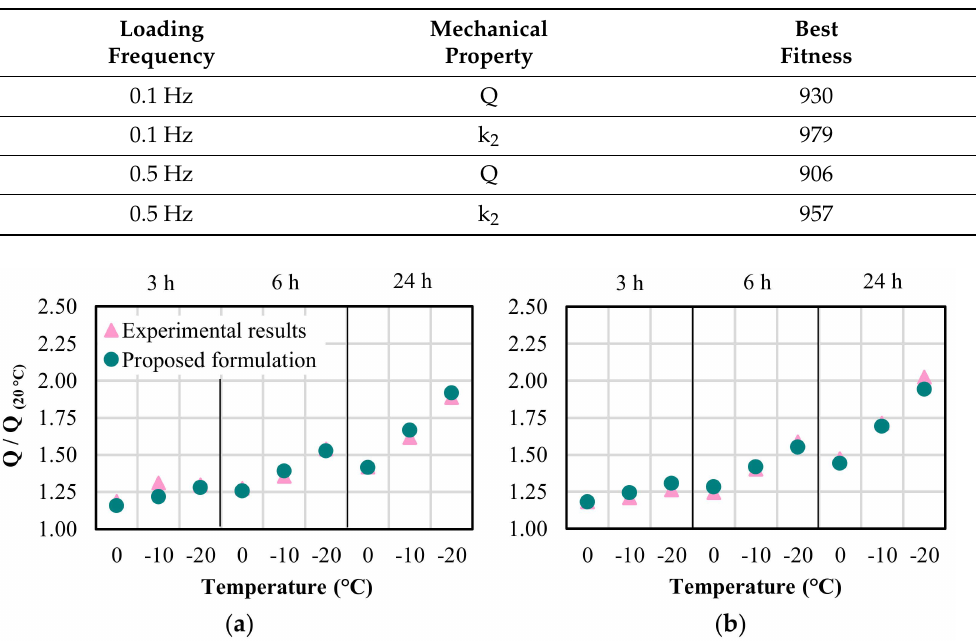
Table 7. Best fitness values of the regression analyses.